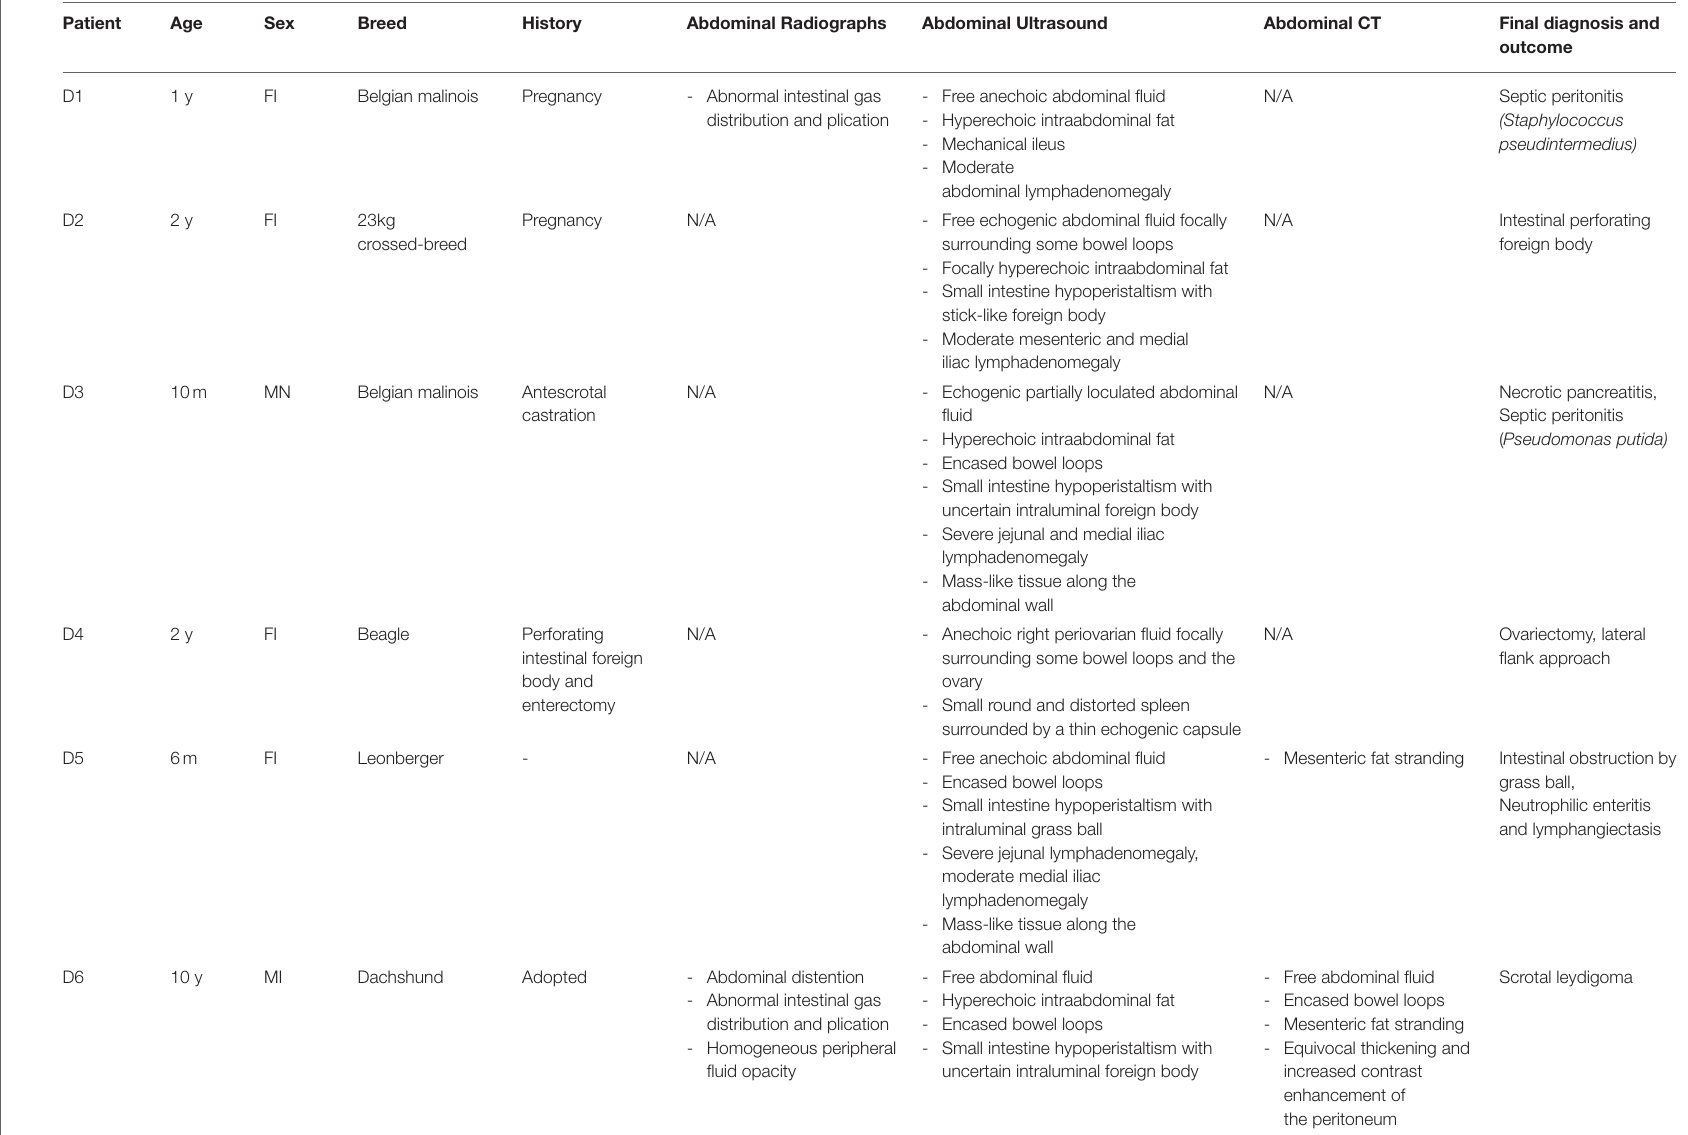
TABLE 1 | Signalement, history and final diagnosis of the nine animals with sclerosing encapsulating